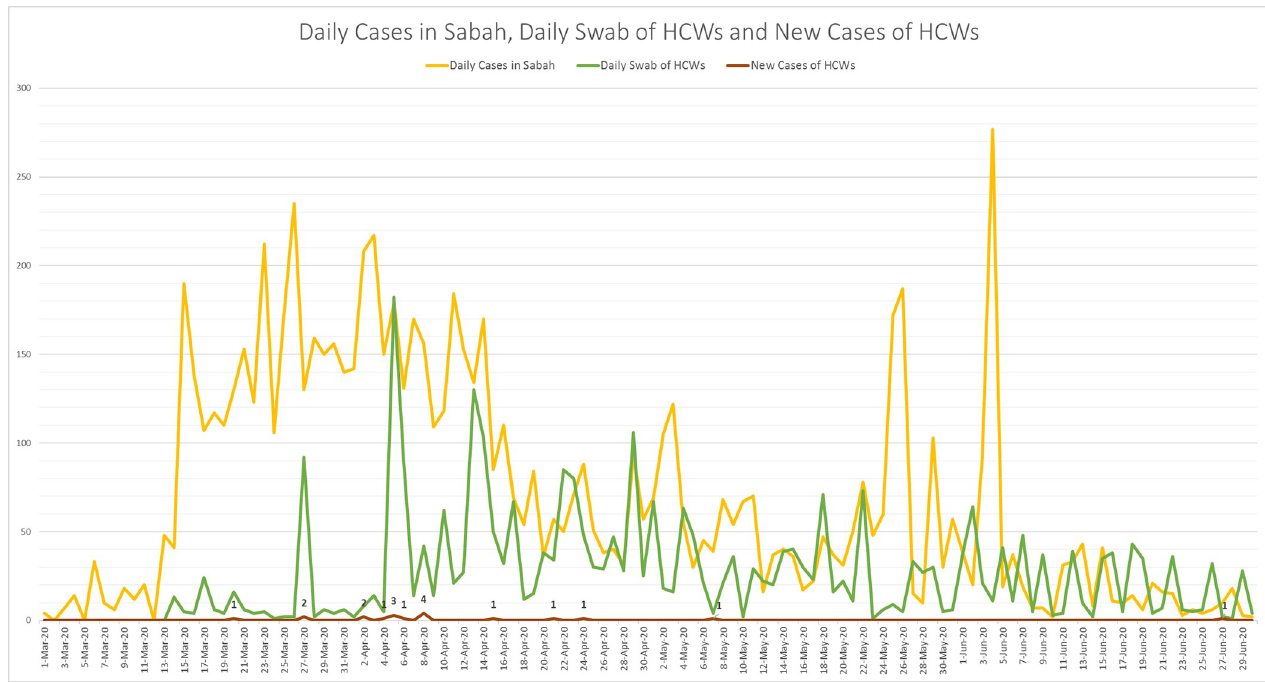
Fig 1. Daily cases in Sabah, daily swab of HCWs and new cases of HCWs. Daily cases of COVID-19 in Sabah, daily swab test for HCWs and new cases of COVID-19 infected HCWs recorded between 1 March 2020 and 30 June 2020; majority of HCWs were infected during the first wave of COVID-19 in Sabah.